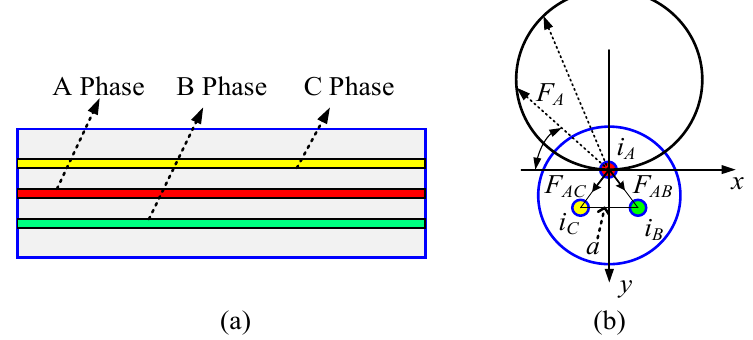
Figure 3. Mechanical analysis of three-phase GIS: ( a ) top view; ( b ) cross-section